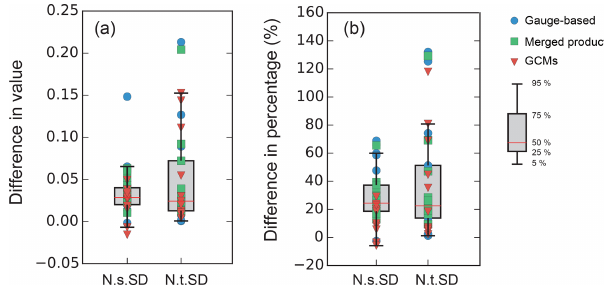
Figure 12. Changes in (a) value and (b) percentage when using U e as the new uncertainty metric compared to classic metrics N.s.std (Eq. 28) and N.t.std (Eq.